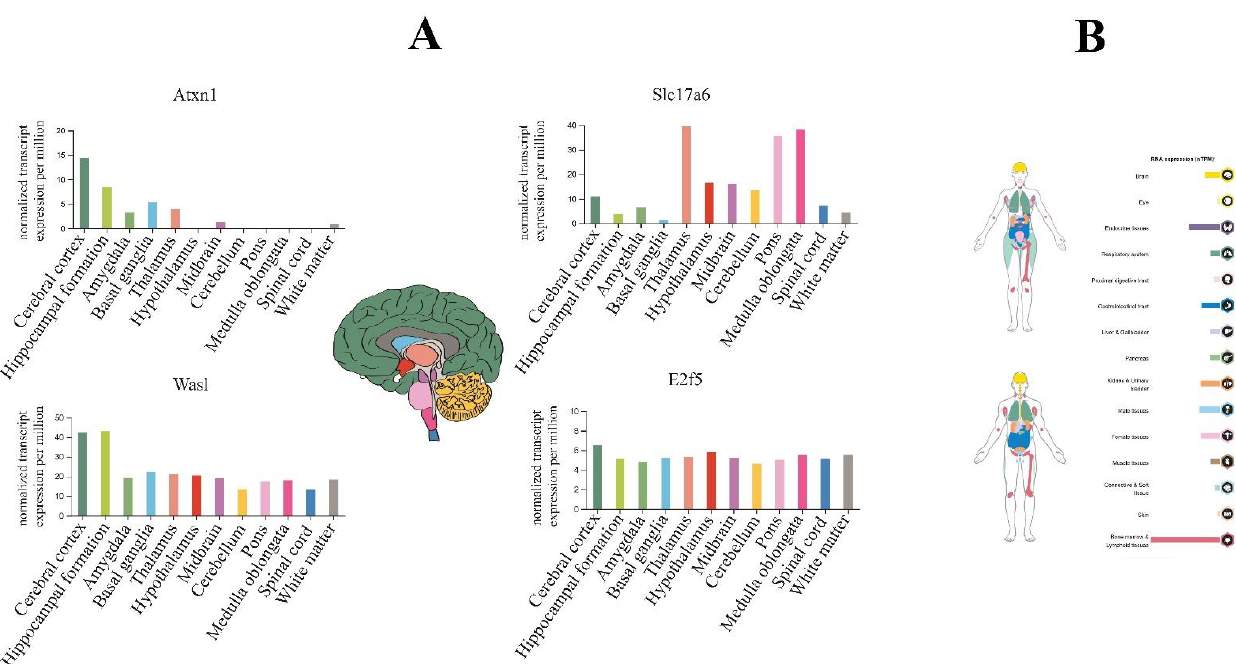
Figure 8. The brain tissue expression of highlighted genes targeted by anxiogenic (miR-19b, miR-92a, and 218) and anxiolytic (miR-34c, Let-7d, and miR-17) miRNA. ( A ) The colored bar plot compares the expression of genes in the brain based on normal transcription per million (nTPM). E2f5 expression in all brain parts, especially in the cerebellar cortex, which includes most of the brain (dark green color area). ( B ) overview of the expression of E2f5 (up image devoted to the female body and below to the male body); it highly expresses in bone marrow and lymphoid tissues, and endocrine tissues.